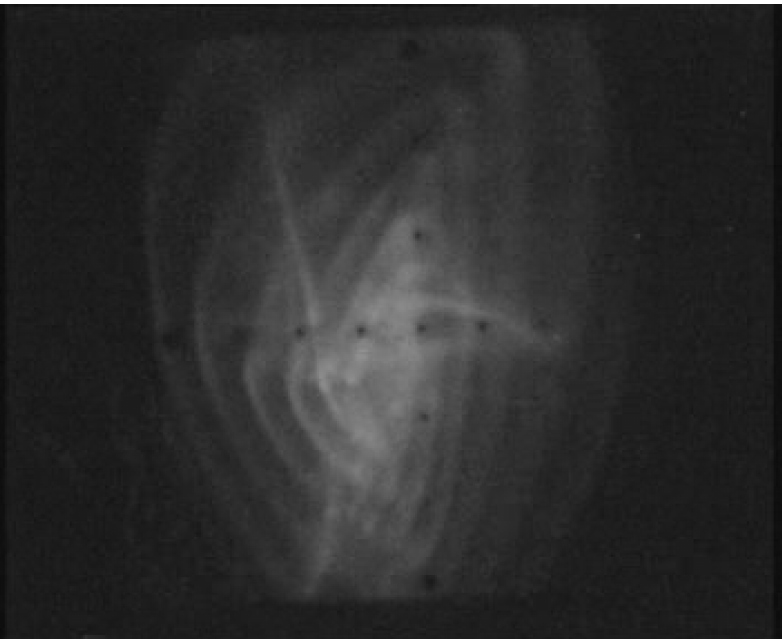
Figure 4. Photograph of ion beam profile on a VT 20cm from the extraction system. The different “triangular rings” (or perhaps better, “wings”) are caused by ions with different m / q (Argon and Helium), guided differently in the stray magnetic field of the ion source. The outermost ring repre- sents the lowest ion charge state of the operating gas, here Argon mixed with Helium, presumably Ar 2 + , m / q = 20. With increasing charge state the ion velocity increases and the effect of the stray magnetic field becomes stronger. The lowest m / q values (for 1 H + , 1 H + already overfocused at the VT location.